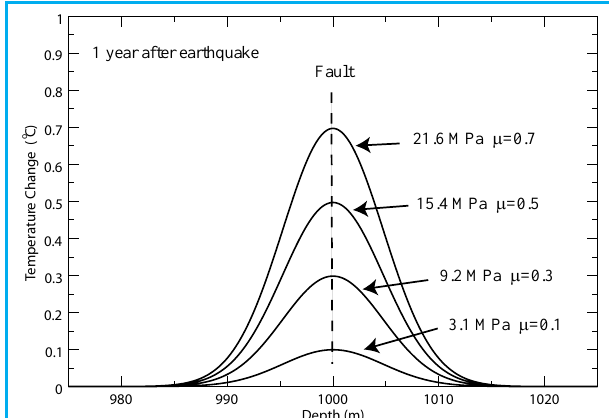
Figure 1. Expected temperature changes at 1000 m depth one year following a fault slip of one meter. The various curves show the changes for different levels of friction on the